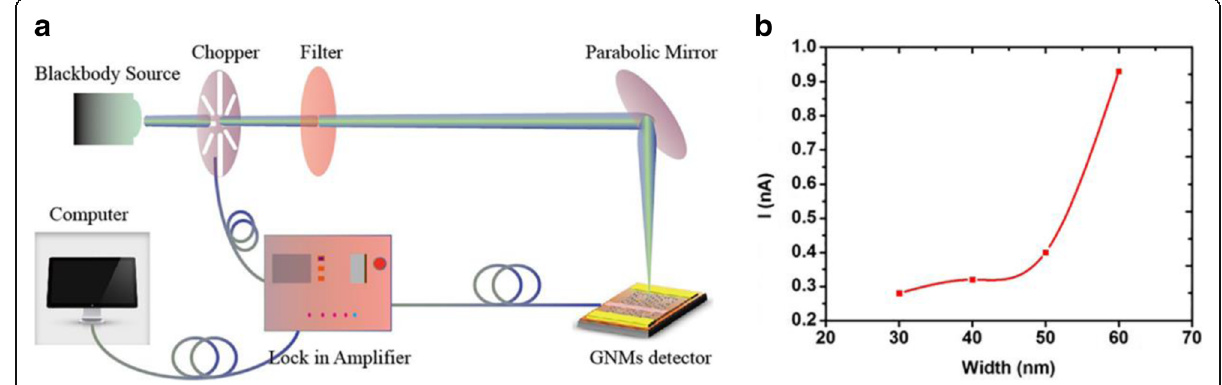
Fig. 6 a Schematic diagram of the terahertz test experimental setup. b Curves of photocurrent I Ph versus neck width of r-GNMs